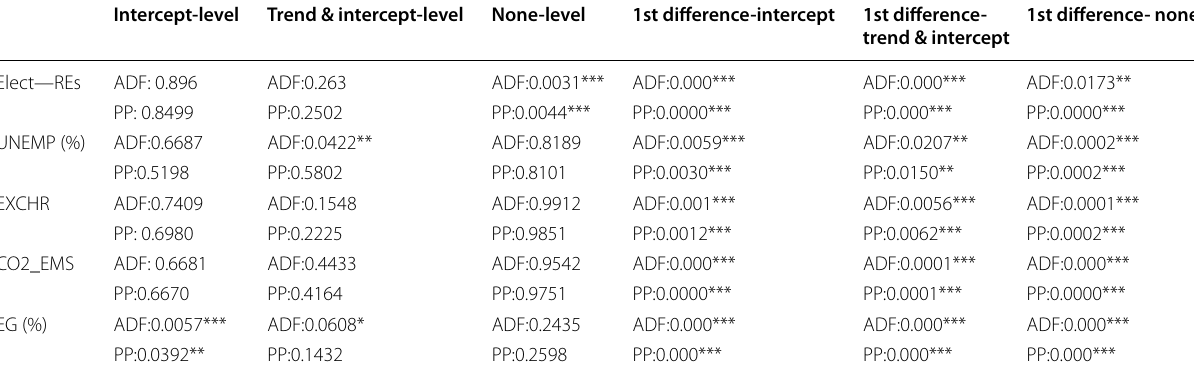
Table 2 Stationarity test